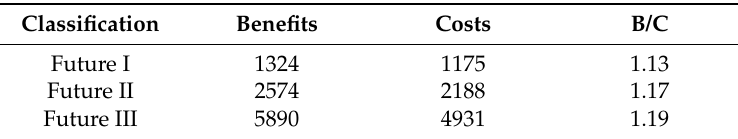
Figure 10. Estimation of damage due to flooding and economic analysis. Table 5. Benefit/cost (B/C) ratio of the improvement in prevention facilities. (Unit: KRW one million, KRW = South Korean